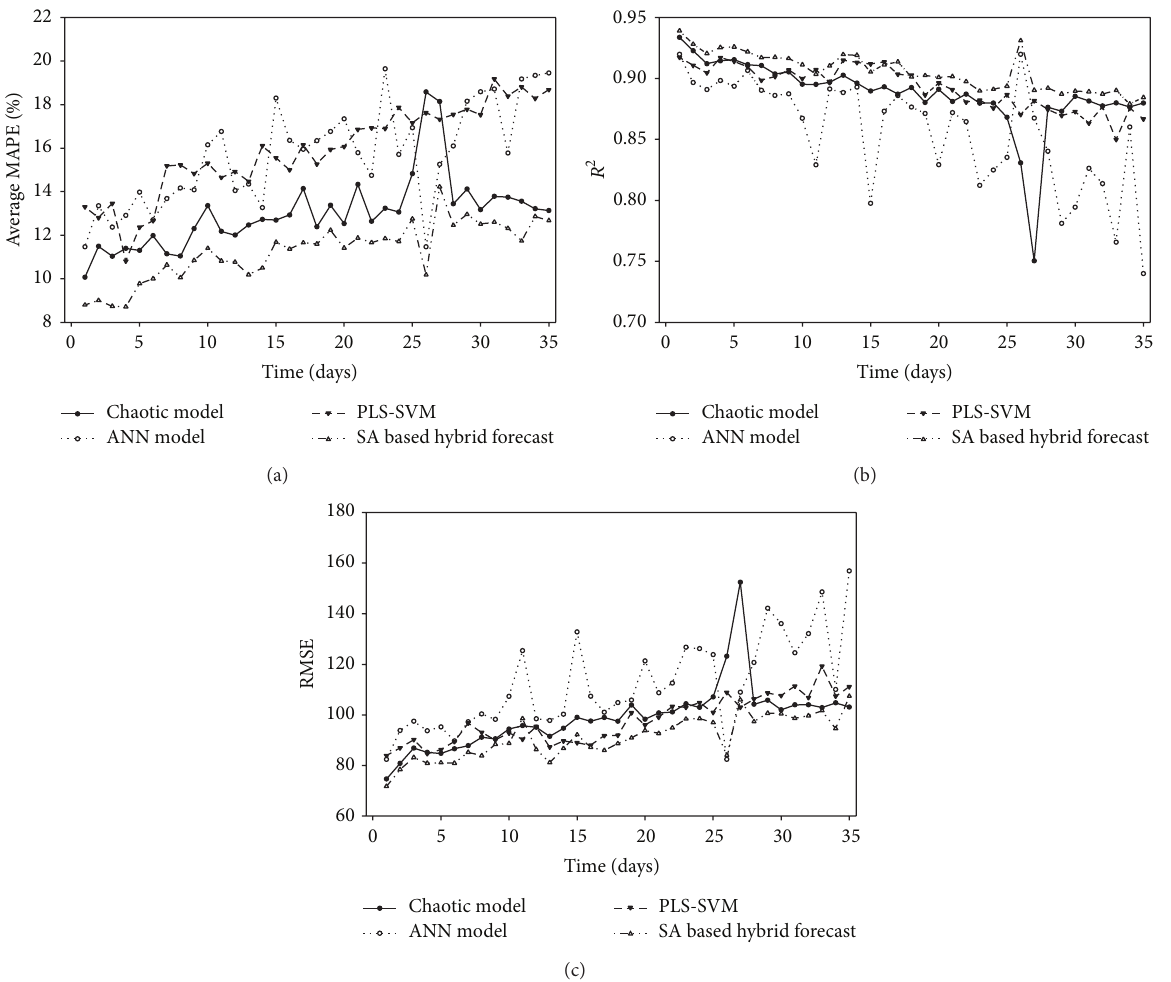
Figure 5: Multidays ahead prediction ability (35 days). (a) Average MAPE. (b) 𝑅 2 . (c)